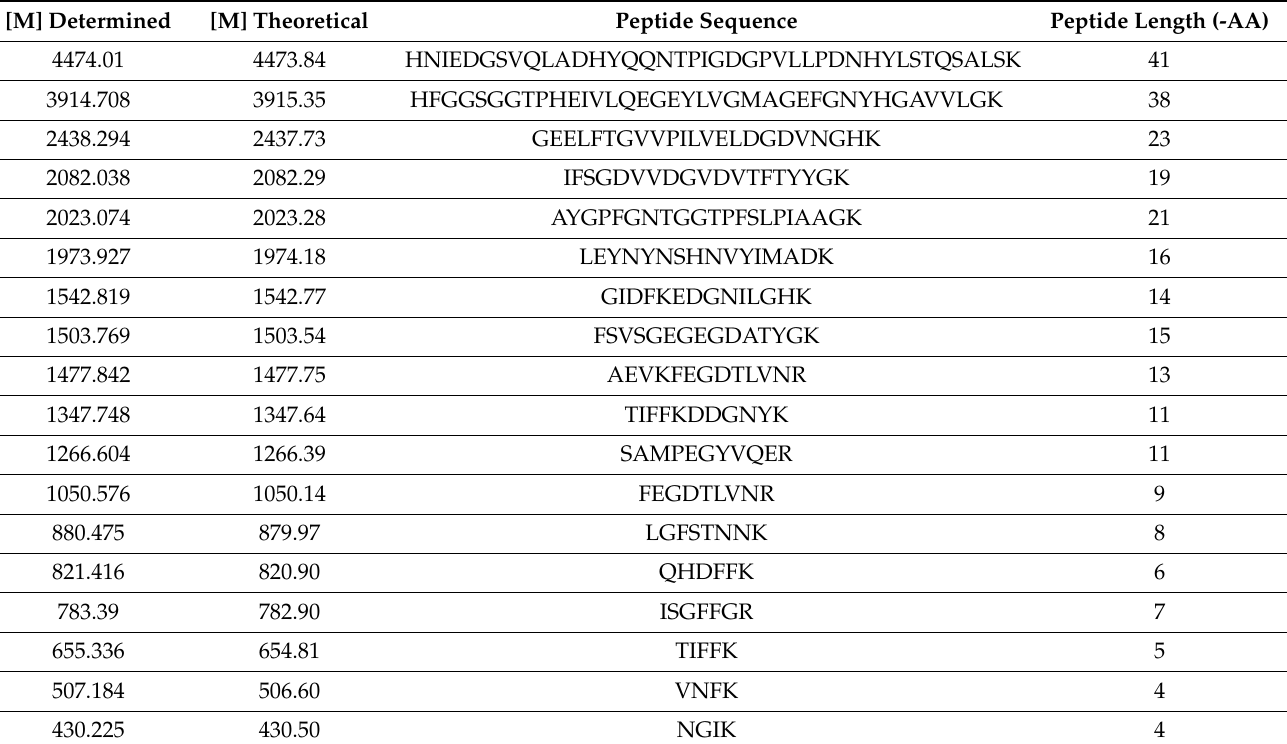
Table 1. Theoretical and peptide masses of the tryptic fragments obtained by MS analysis. AA = amino acid. M = molecular